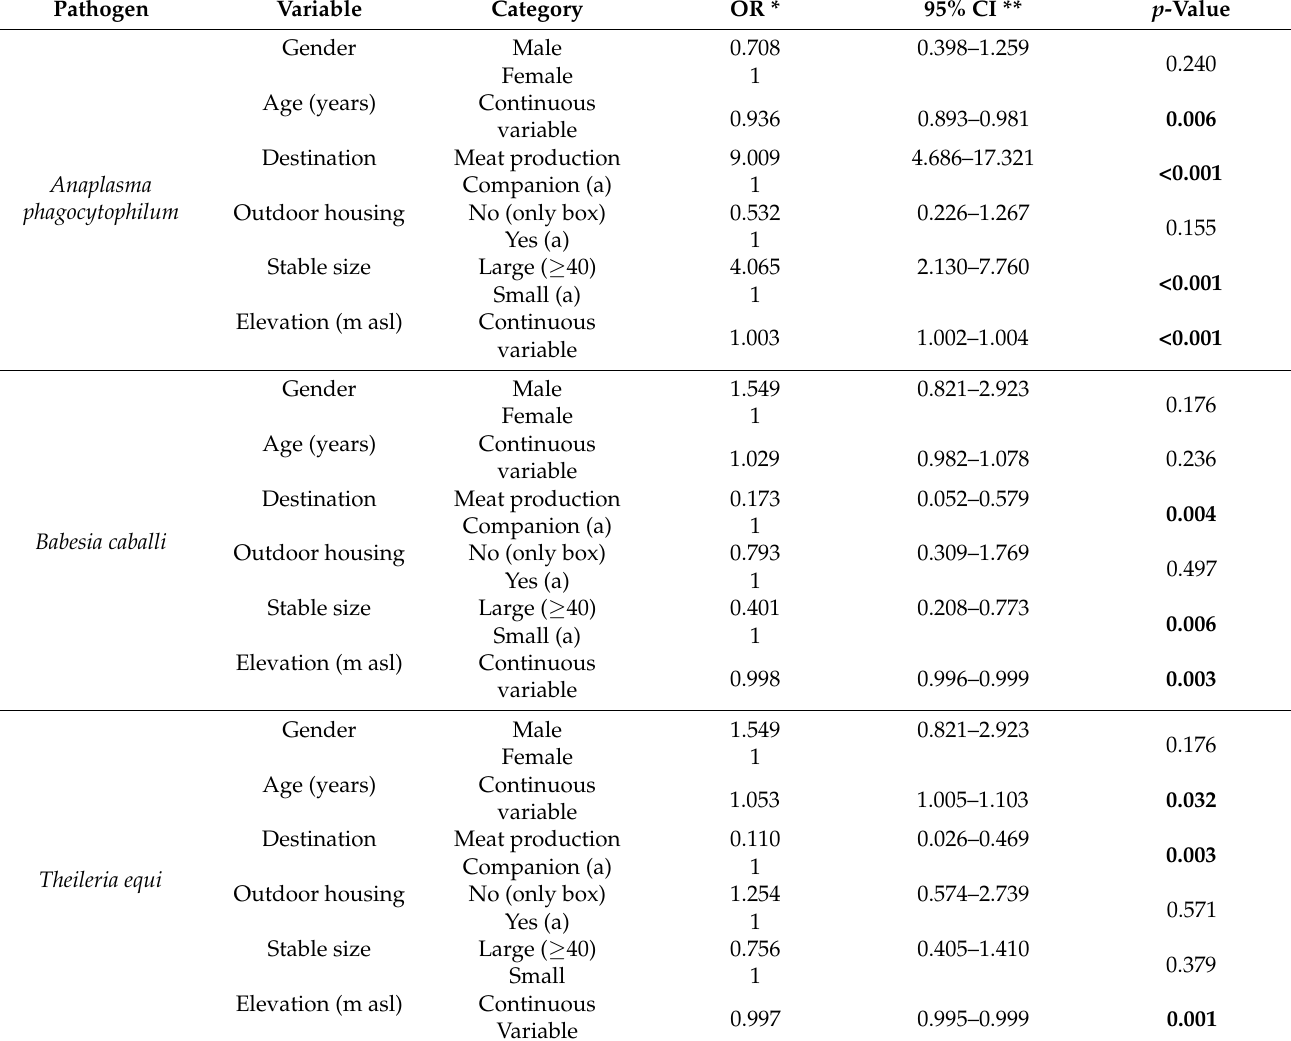
Table 2. Potential risk factors associated with Anaplasma phagocytophilum , Babesia caballi and Thei- leria equi seropositivity in horses reared in northern Italy as assessed via univariate analysis. Test performed at 95% significance level. Note: p -values ≤ 0.1 considered